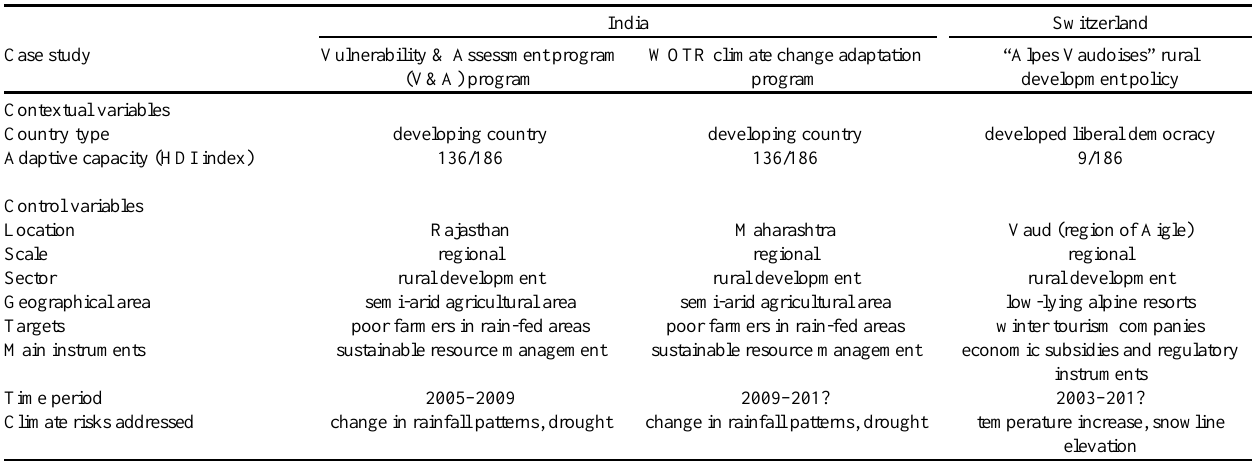
Table 2. Comparative research